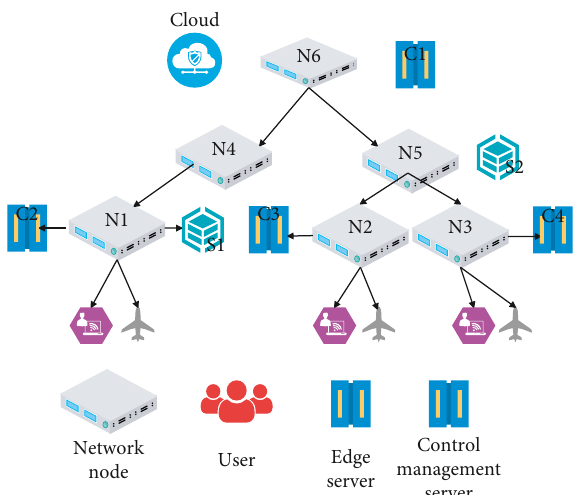
Figure 9: Design of edge network for smart